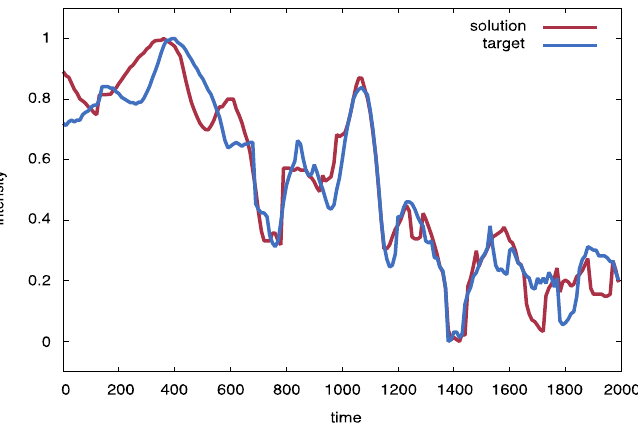
Figure 20. Synthetic test—. In blue, the synthetic light-curve created with VISONE, while in red the light-curve found by the genetic algorithm are shown. Table 2. The initial attitude parameters found by the proposed method on a synthetic dataset in